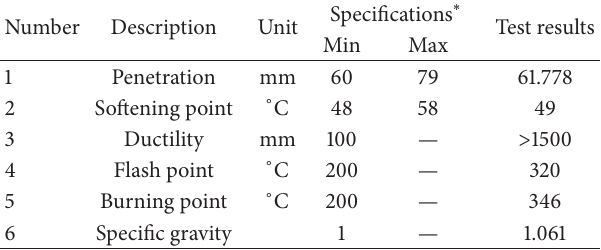
Table 1: Properties of AC